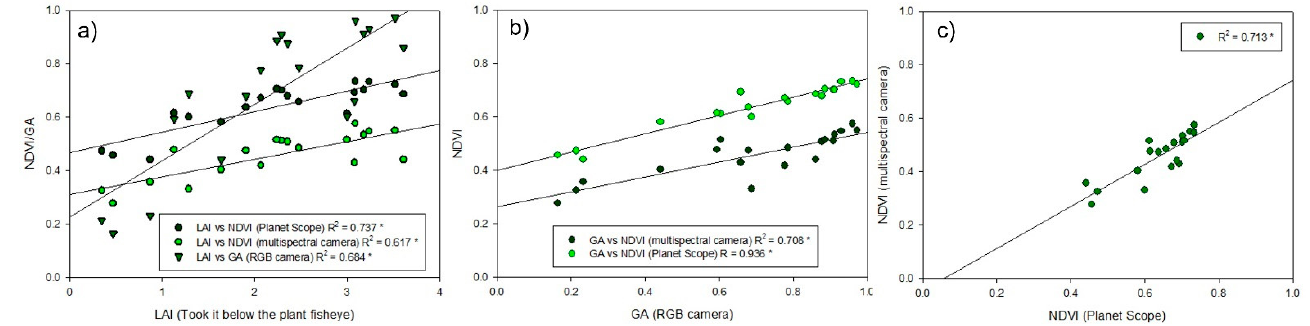
Figure 8. Coefficient of determination (R 2 ) of the different indices of aboveground biomass against each other, all taken on the same day (28 May 2019). ( a ) In the x axis, the LAI is taken with the fisheye (from below the plant) and the y axis shows the NDVI calculated from PlanetScope (nanosatellite), the NDVI calculated from the multispectral sensor (at 5 m), and the GA index extracted from the RGB camera (at 5 m). ( b ) The GA index from the camera compared against the two different NDVI sources: the multispectral sensor and the nanosatellite. ( c ) The comparison between the NDVI from the nanosatellite and the NDVI from the field multispectral camera. (* = Pearson correlation significant with p <